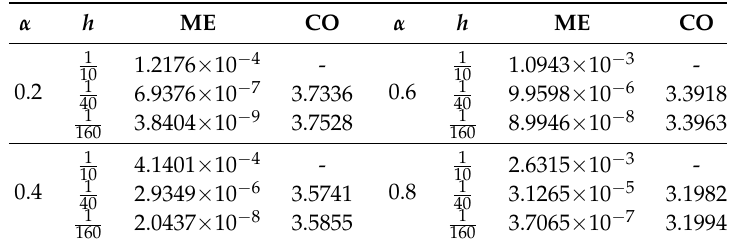
Table 4. Numerical results for Example 4.